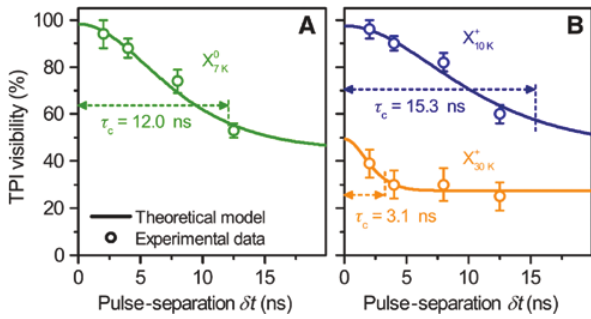
Figure 15: Two-photon interference visibilities of consecutively emitted single photons in dependence on the pulse separation δ t